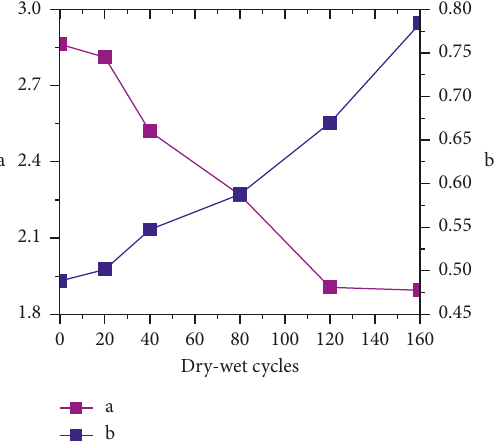
Figure 10: Model parameters (SE1 specimen). Figure 12: Model parameters (SE3 specimen). Table 3: The coefficient of exponential function.